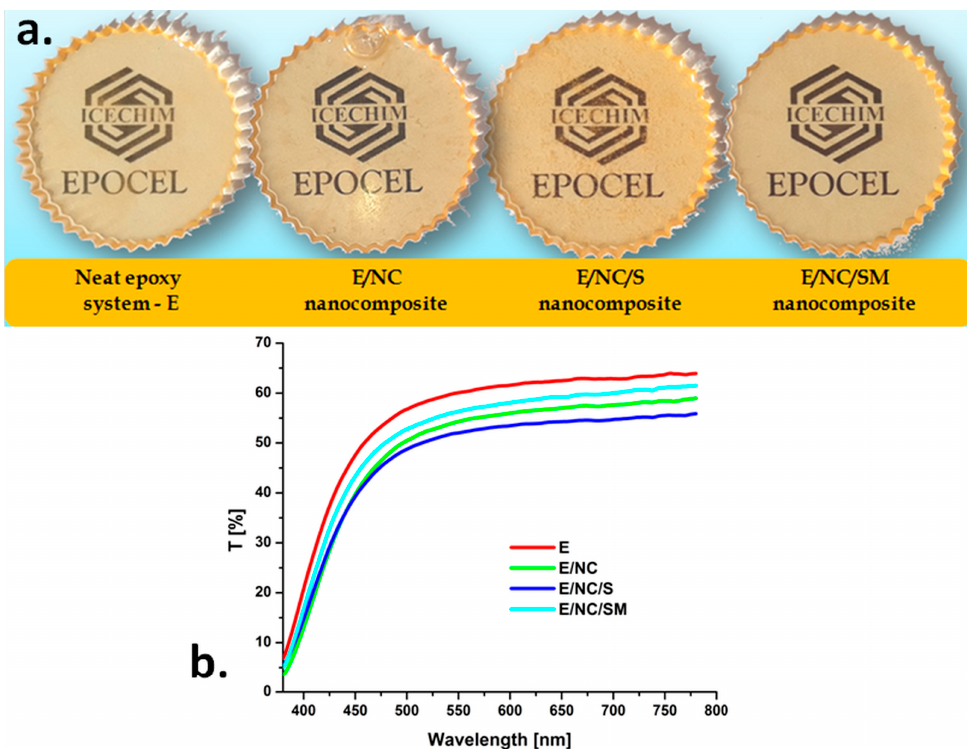
Figure 6. Images of the cured neat epoxy matrix and epoxy/NC nanocomposites indicating their transparency ( a ); Light transmittance measurements versus the wavelength for the cured neat epoxy matrix and epoxy/NC nanocomposites ( b ).